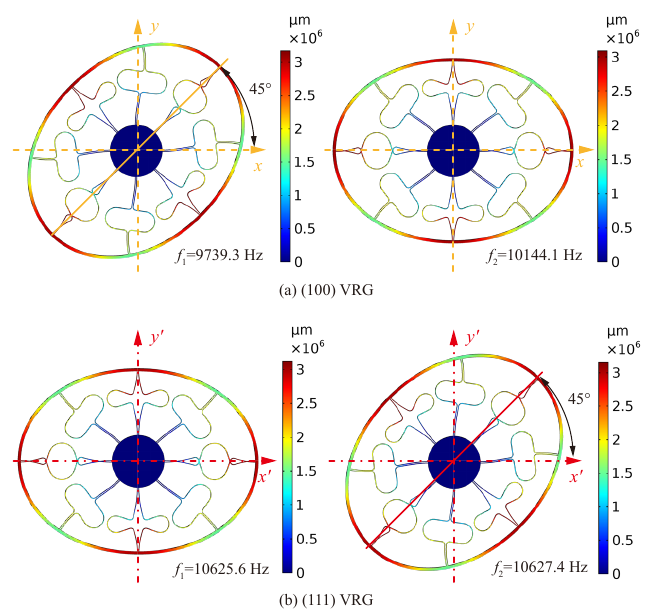
Figure 5. Modal shapes and resonant frequencies of (100) and (111) VRGs.